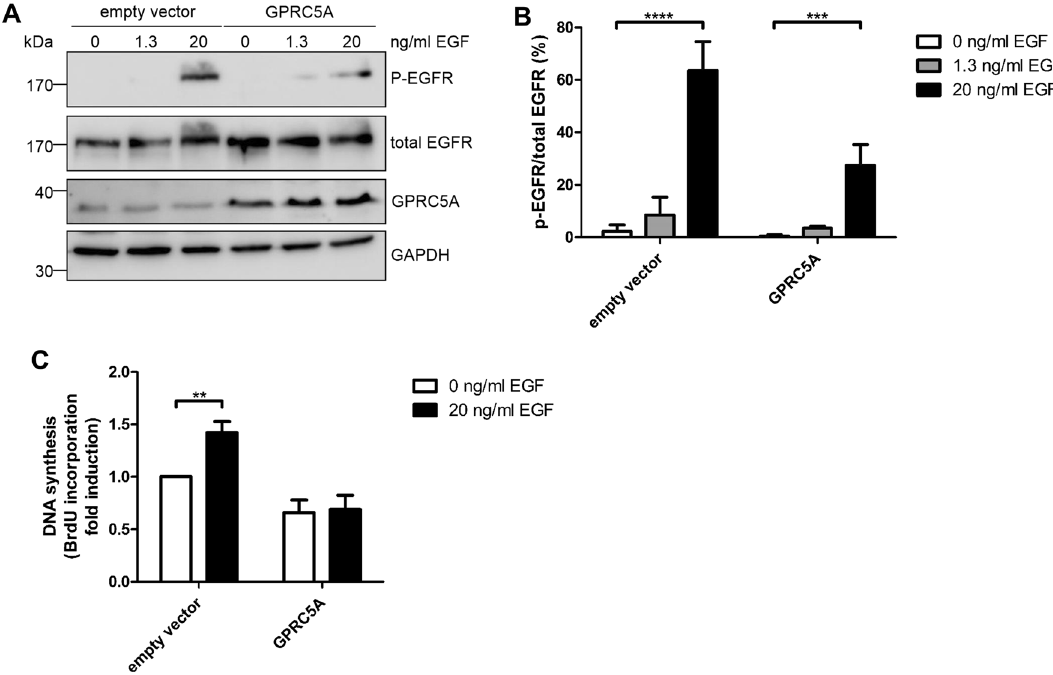
Figure 5. Expression of GPRC5A reduces EGF stimulated phosphorylation of EGFR. ( A ) Western Blot analysis of EGFR phosphorylation following transient expression of GPRC5A. In MCF10A cells, RAI3 expression was induced by viral transduction using pMiBerry-GPRC5A or empty vector as control. After serum starvation for 48 h, the cells were stimulated with 0, 1.3 or 20 ng/ml EGF for five min. Representative Western Blots of three independent experiments are shown. GAPDH was used as loading control. ( B ) Quantification of A. Data of three independent experiments were quantified and analyzed using two-way ANOVA. ***p < 0.001, ****p < 0.0001. ( C ) In MCF10A cells GPRC5A was expressed by viral transduction. After serum starvation for 48 h, the cells were stimulated with 20 ng/ml EGF and incubated with BrdU for 4 h. DNA synthesis was normalized to the unstimulated empty vector control. Data of three independent experiments were quantified and analyzed using two-way ANOVA. **p <